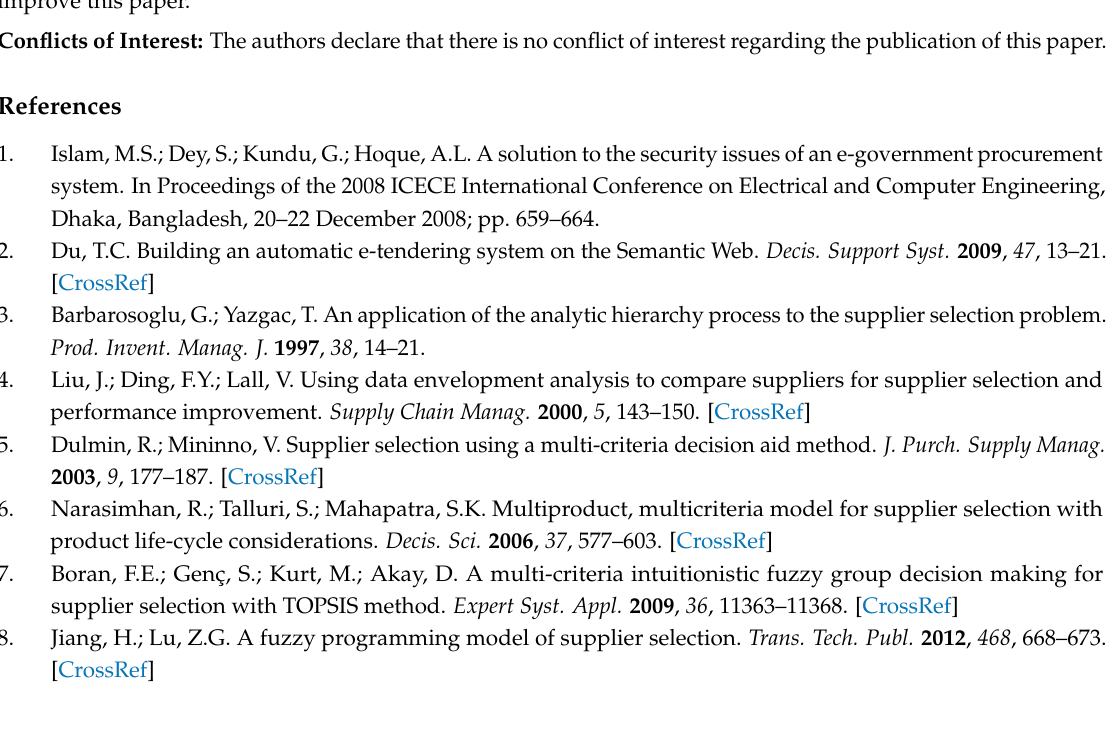
Supplementary Materials: All the data and the code of the experiment are displayed in the Figshare